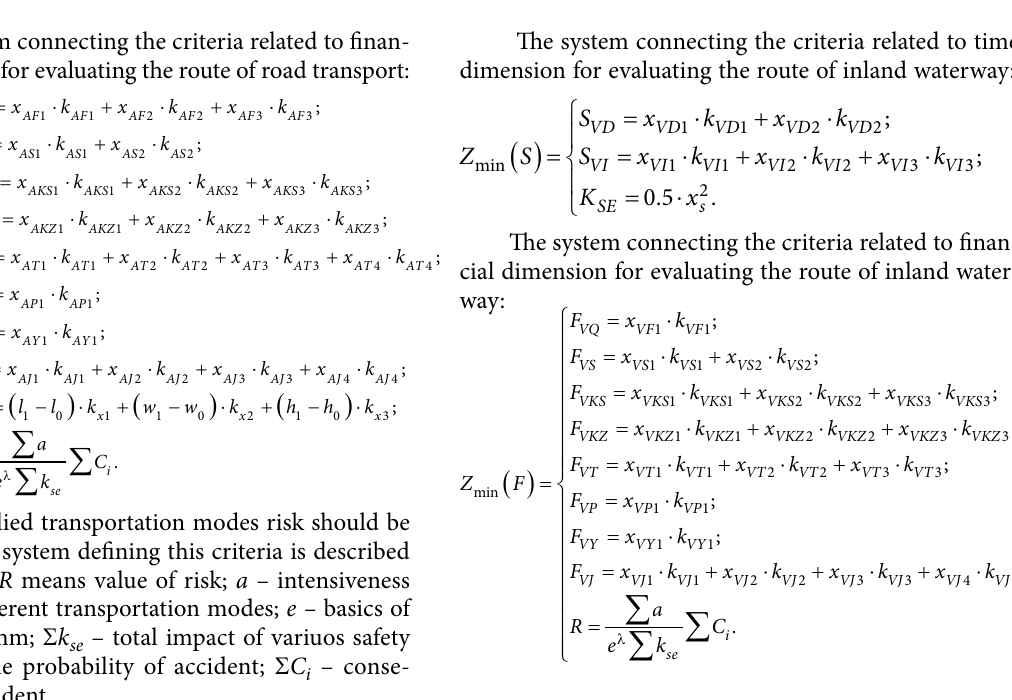
Fig. The algorithm for selecting a route for transporting oversize heavyweight